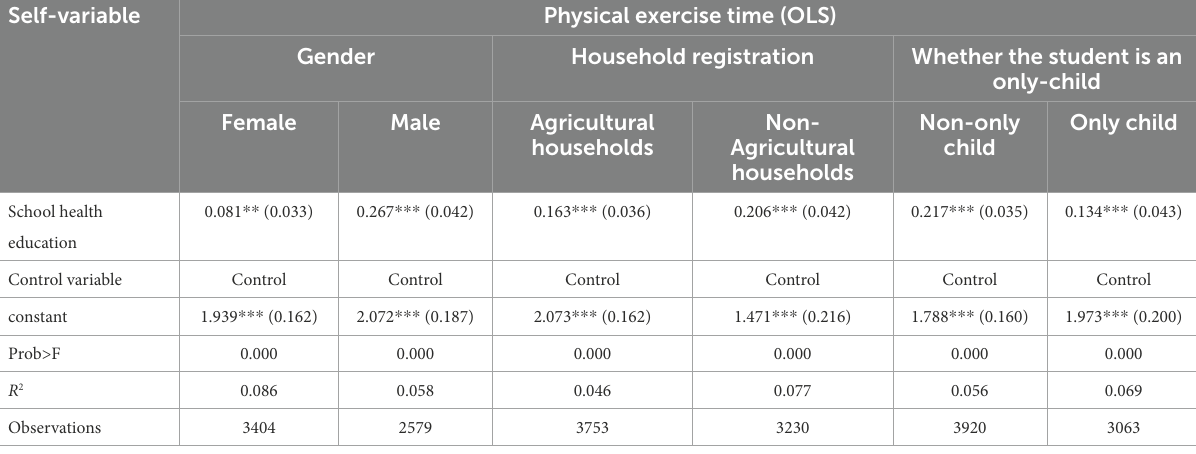
TABLE 6 Heterogeneity of school health education affecting students’ physical exercise